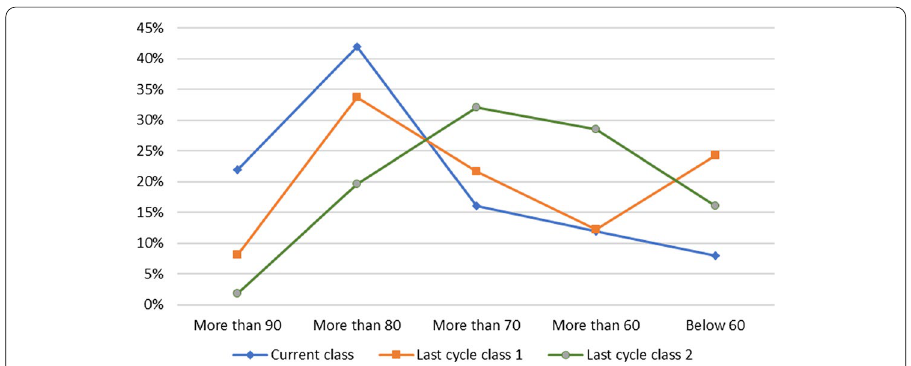
Fig. 4 Effect stage data curve of three different teaching modes